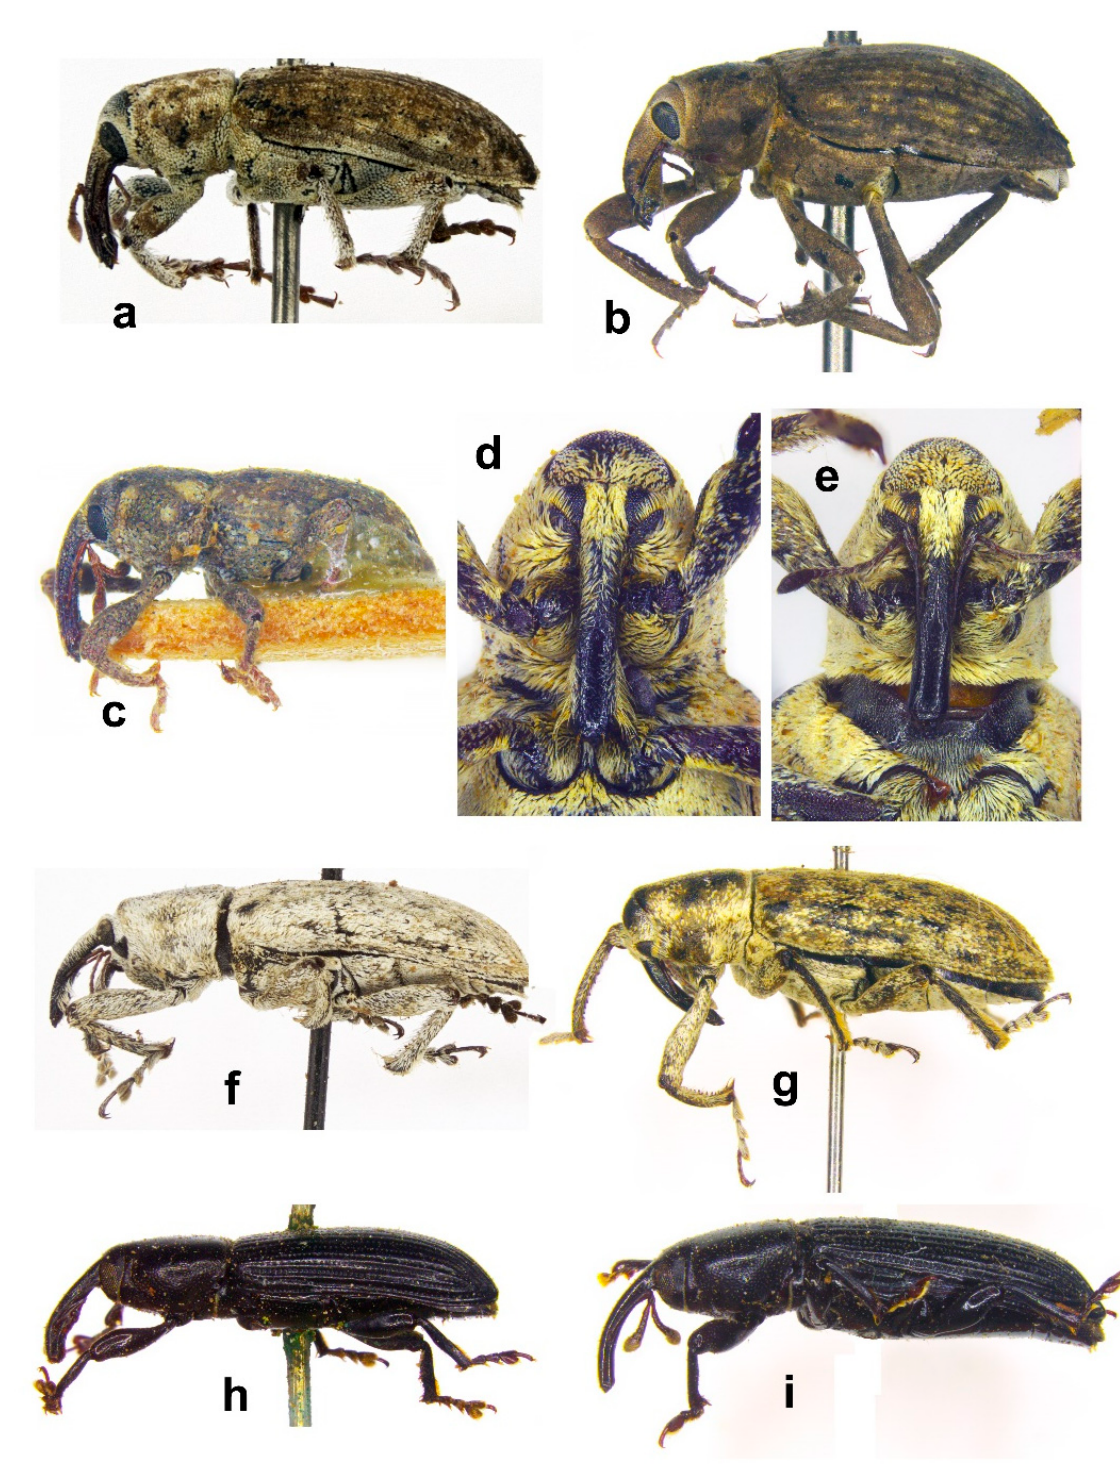
Figure 11. Habitus ( a ) Icaris sparganii , male, lateral view; ( b ) Picia syriaca , male, lateral view; ( c ) Echinocnemus reitteri , female, lateral view; ( d ) Arthrostenus fullo , head and pronotum, male, ventral view; ( e ) A. fullo , head and pronotum, female, ventral view; ( f ) A. fullo , male, lateral view; ( g ) A. fullo , female, lateral view; ( h ) Aorus anthracinus , male, lateral view; ( i ) A. anthracinus , female, lateral view (not on the same scale).